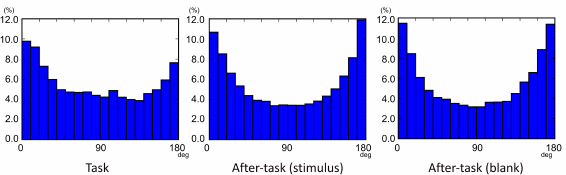
Figure-04. Gaze-metric statistics: distributions of gaze-shift angles ( 𝛽𝑠 ).